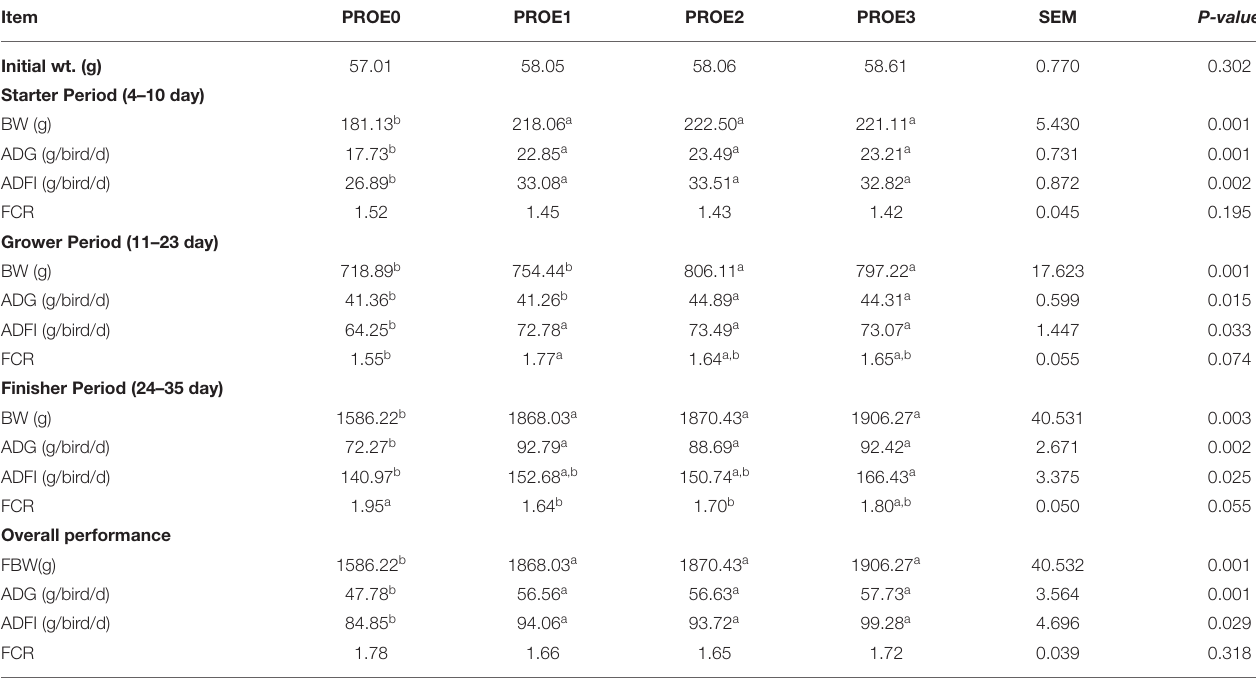
TABLE 2 | The effect of PROE supplementation on the growth performance parameters of broiler chickens. Item PROE0 PROE1 PROE2 PROE3 SEM